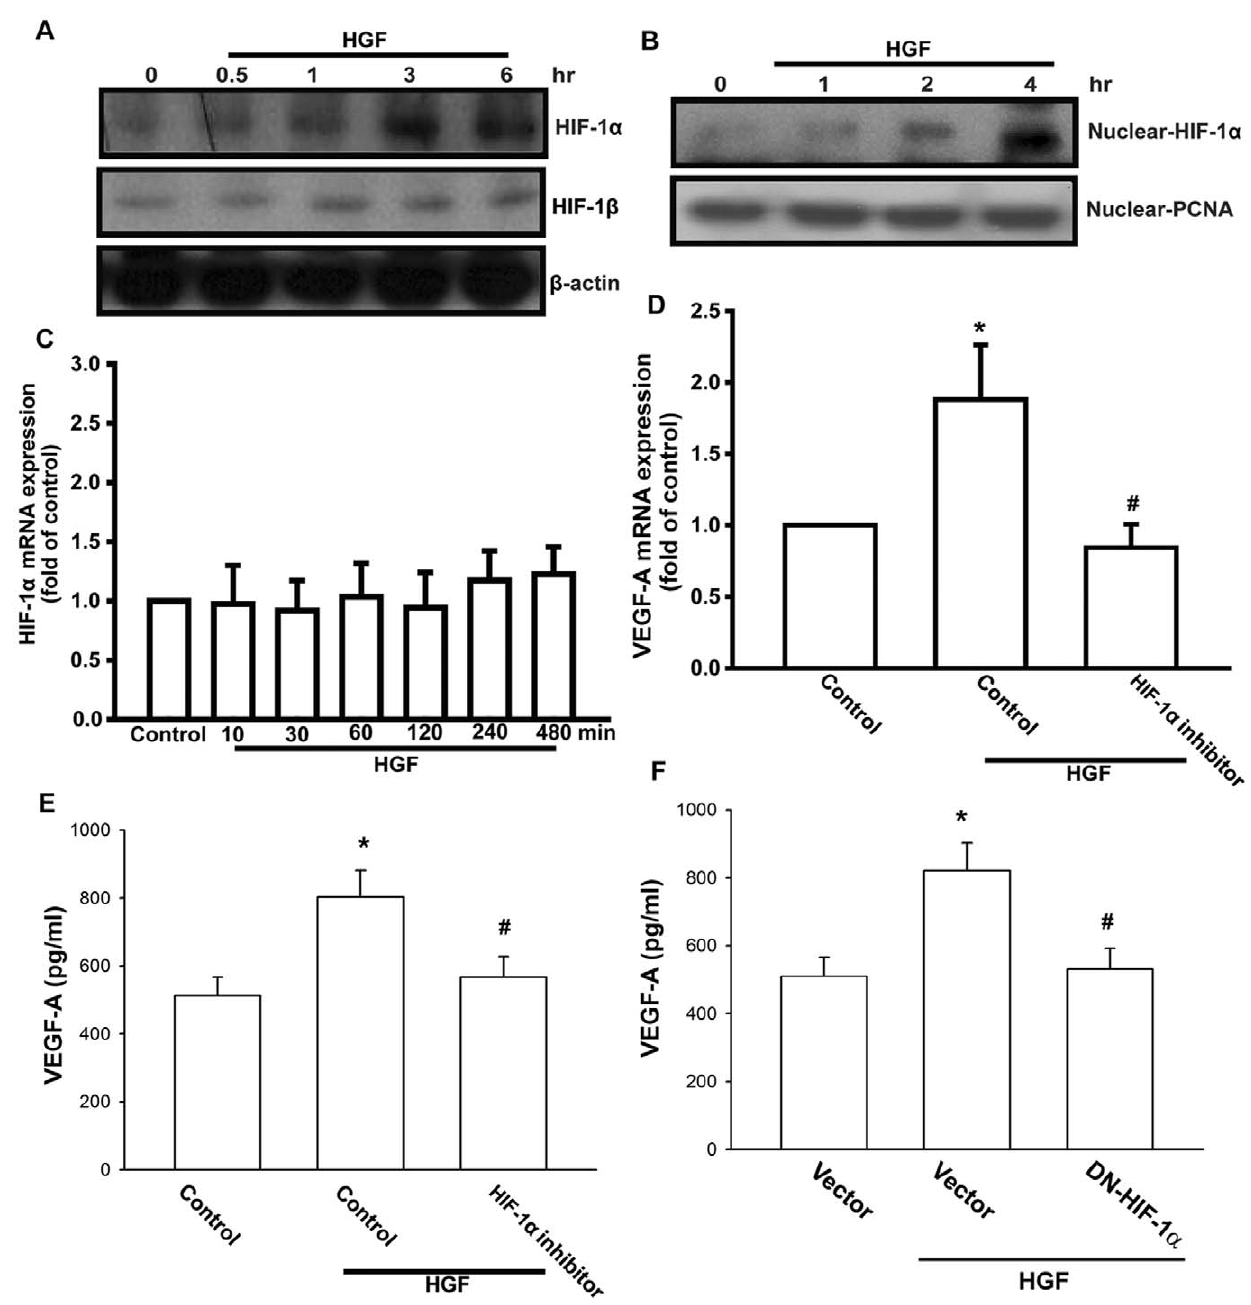
Figure 5. HGF enhances HIF-1 a activation. (A) OASFs were incubated with HGF for indicated time intervals, and HIF-1 a expression was examined by Western blotting. (B) OASFs were incubated with HGF for indicated time intervals, and nucleus HIF-1 a accumulation was determent by Western blotting. (C) OASFs were incubated with HGF for indicated time intervals, and HIF-1 a mRNA expression was examined by qPCR. (D&E) OASFs were pretreated for 30 min with HIF-1 a inhibitor followed by treatment with HGF for 24 h, the VEGF-A expression was examined by qPCR and ELISA. (F) OASFs were transfected with HIF-1 a mutant followed by stimulation with HGF for 24 h, the VEGF-A expression was examined by ELISA. Results are expressed as the mean 6 S.E. *, p , 0.05 compared with control; # , p , 0.05 compared with HGF-treated